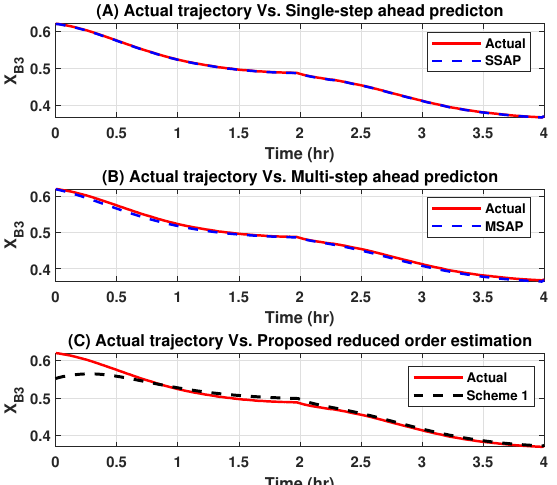
Figure 6. Trajectories of the actual states X B 3 , the single-step ahead prediction ( A ), the multi-step ahead prediction using the LSTM model ( B ), and the estimated target variable using the proposed reduced-order estimator in Scheme 1 ( C ).